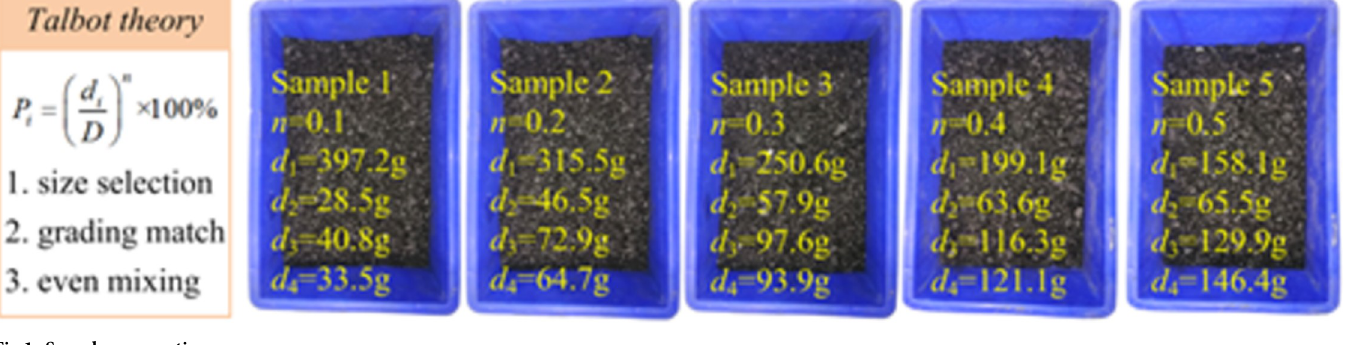
Fig 1. Sample preparation